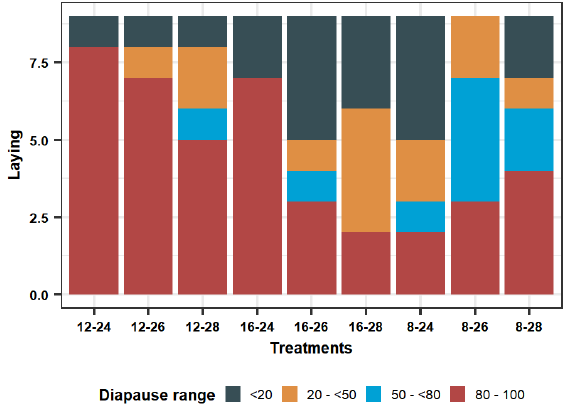
Figure 2. Distribution of the percentage of diapause for line C6 in four ranges (<20, 20-50, 50-80 and 80-100) by combination of photoperiod and temperature. The x-axis labels represent the treatments, the first number the photoperiod and the second the temperature